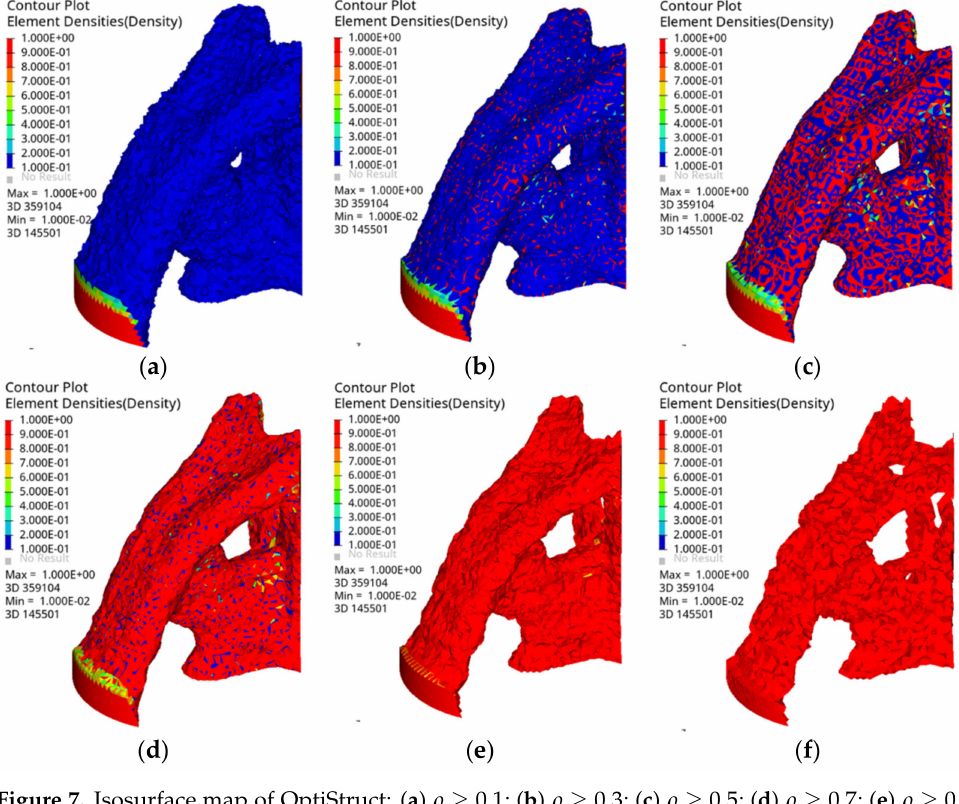
Figure 7. Isosurface map of OptiStruct: ( a ) ρ ≥ 0.1; ( b ) ρ ≥ 0.3; ( c ) ρ ≥ 0.5; ( d ) ρ ≥ 0.7; ( e ) ρ ≥ 0.9; ( f ) ρ = 1.0.